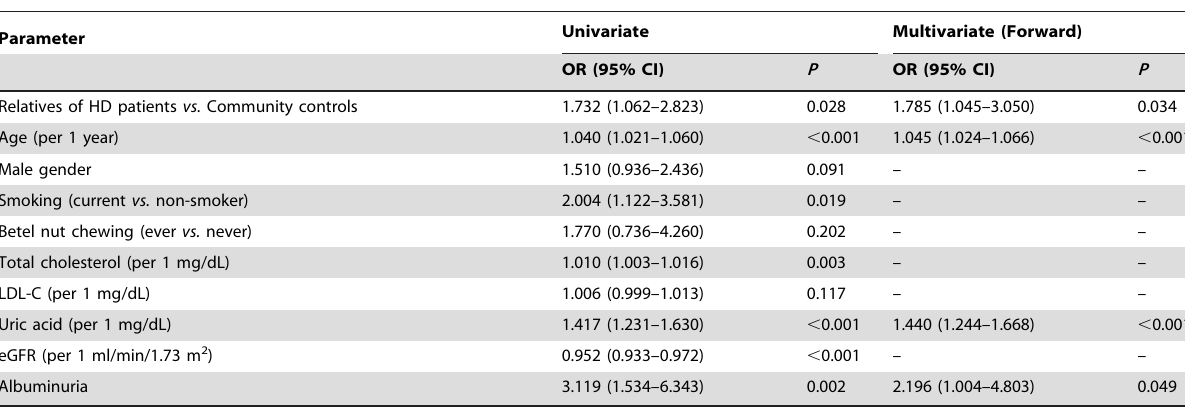
Table 2. Determinants of MetS in all subjects.